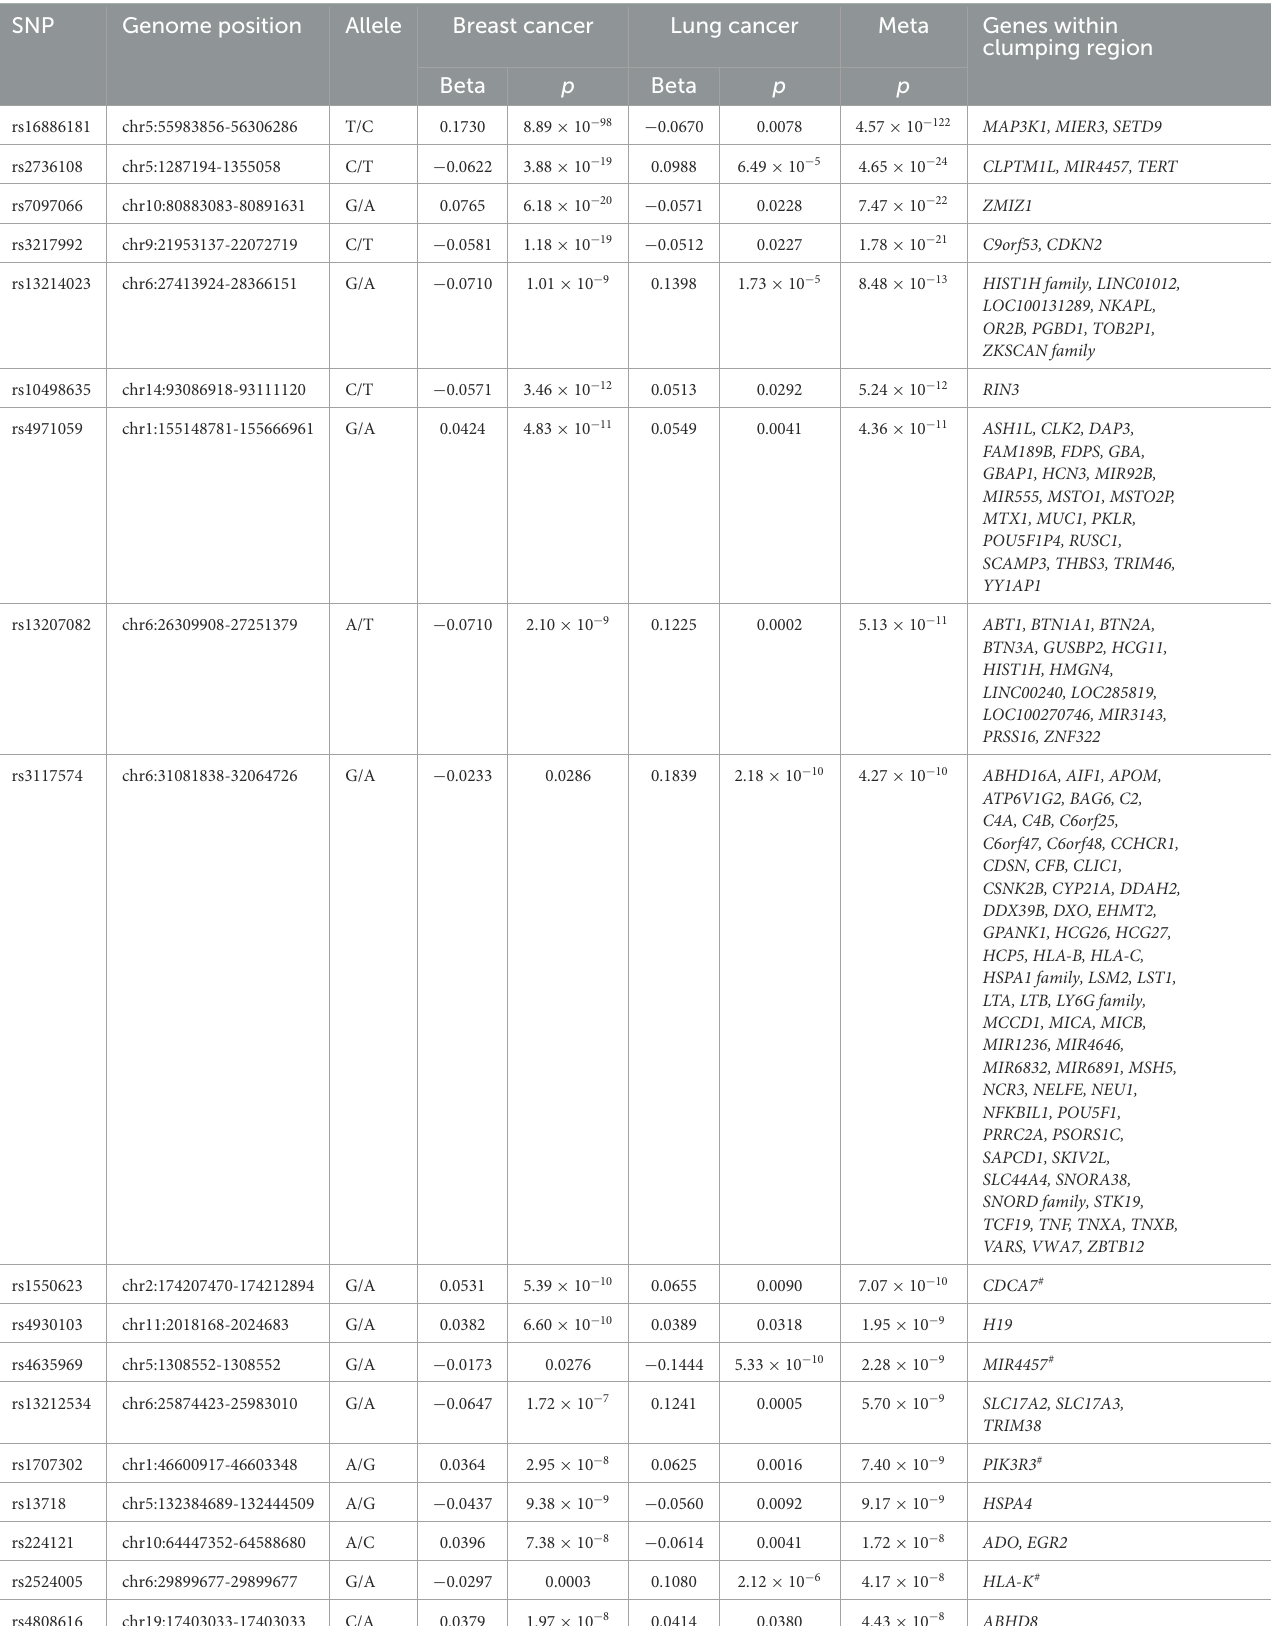
TABLE 3 Cross-trait meta-analysis result between breast and lung cancers ( p meta < 5 × 10 − 8 ; single-trait p < 0.05). SNP Genome position